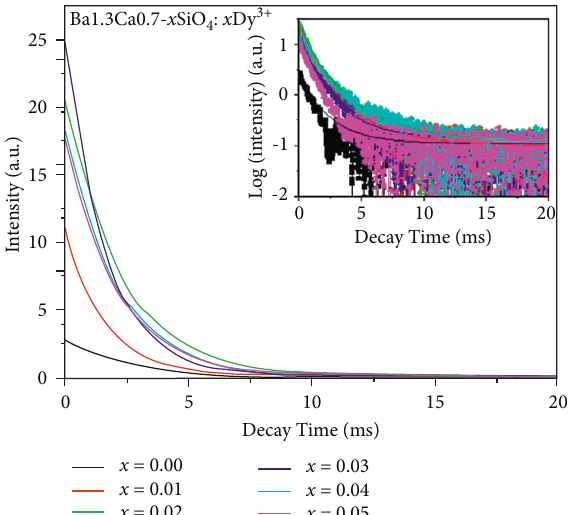
Figure 8: PL decay curve for the silicate phosphors, Ba the plot of “Log (Intensity) vs. Decay Time.”